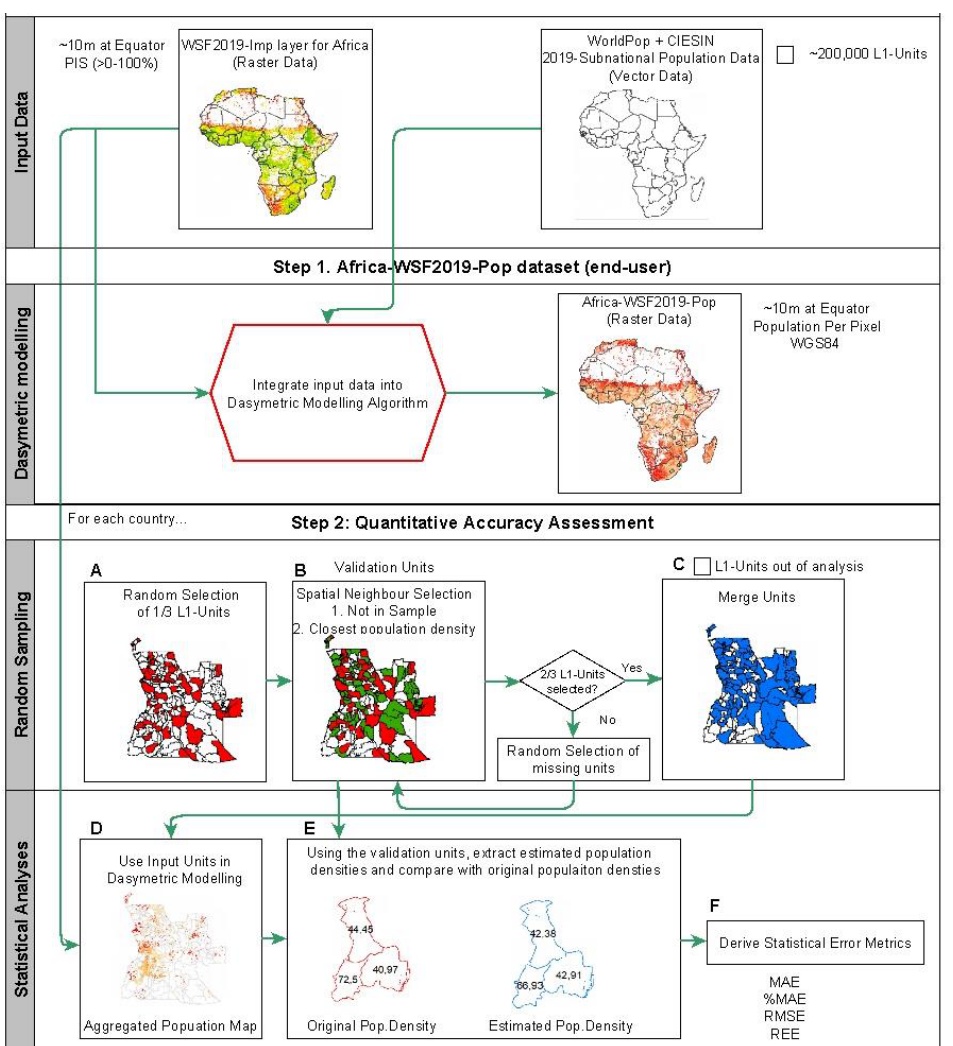
Figure 1. General workflow for the modelling and validation of the WSF2019-Pop dataset for Africa.